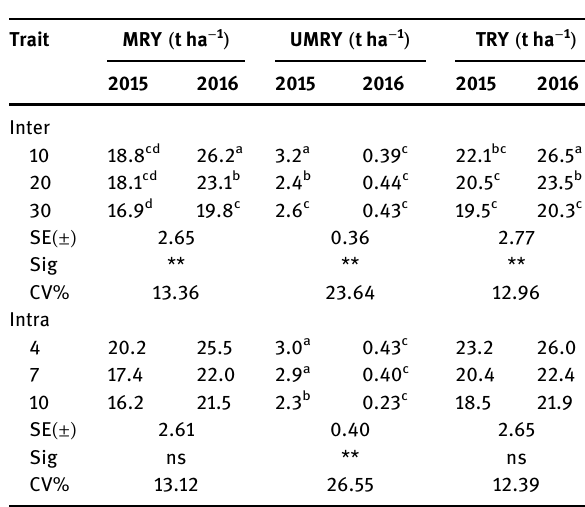
Table 5: Interaction e ff ects of spacing and season on the root yield of carrot as combined over